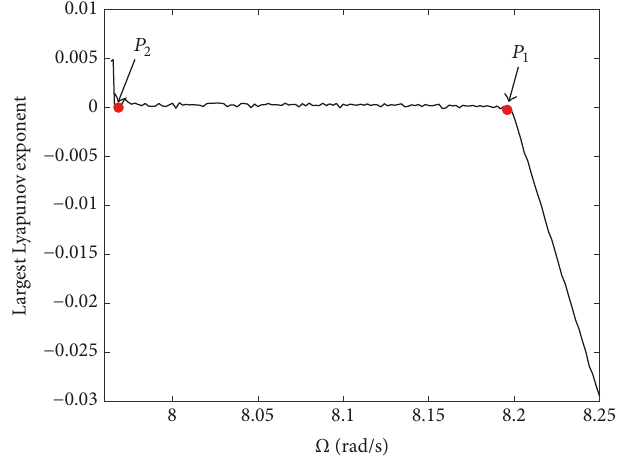
Figure 15: Evolution of the largest Lyapunov